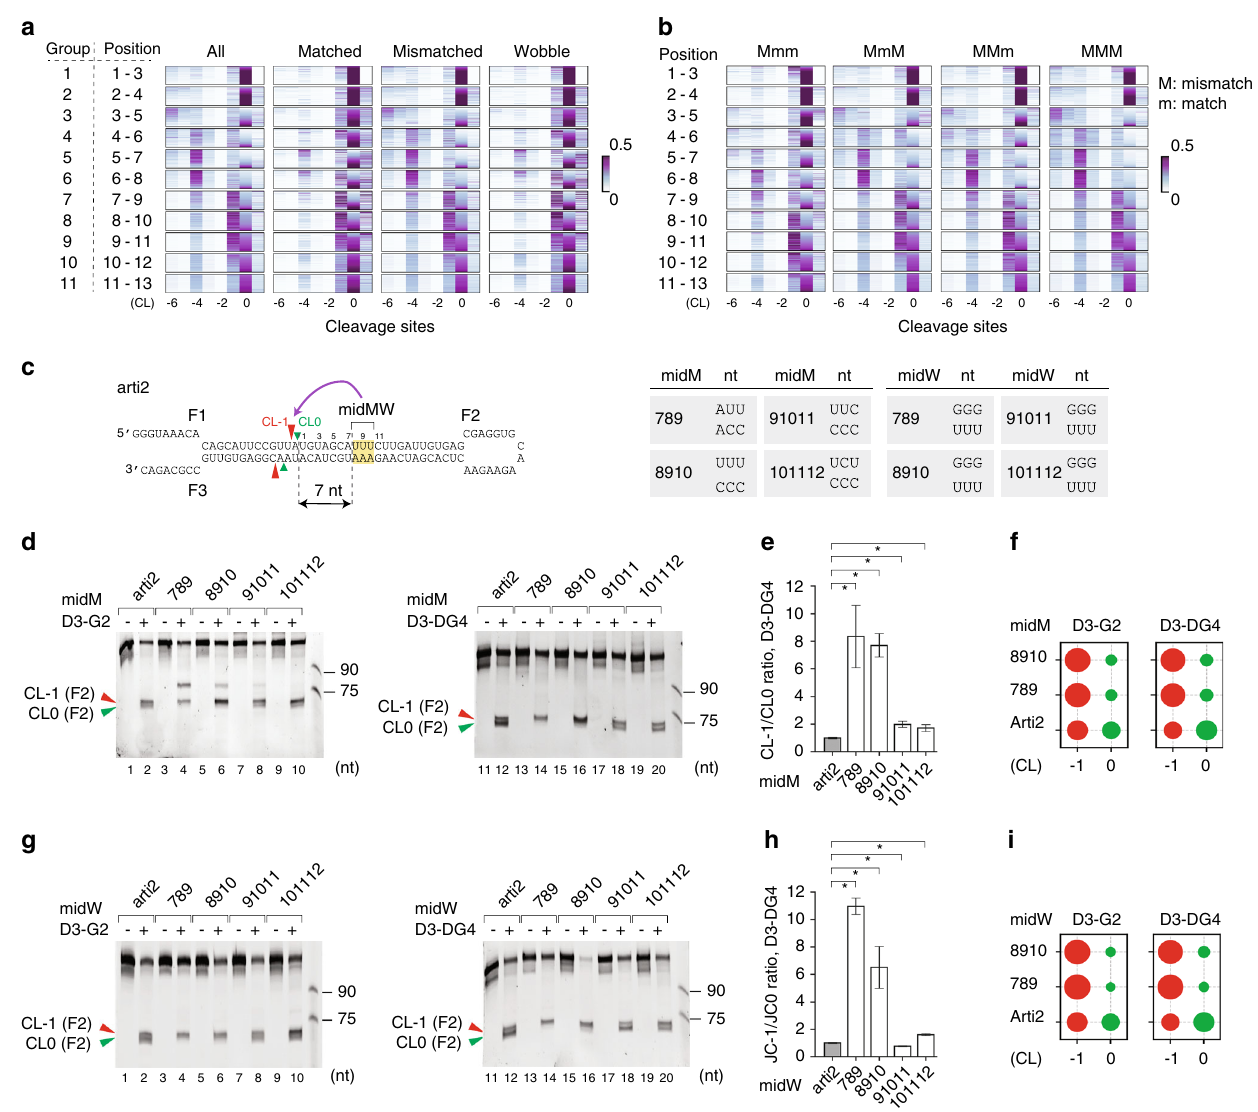
Fig. 2 MidMW causes the alternative cleavage of DROSHA. a The relative positional cleavage frequency of DROSHA at different positions ranging from 7 to 14 nt from the basal junction of each variant from an arti1 individual group, colored according to the color bar (right). Number “ 0 ” indicates the cleavage site 13 nt from the basal junction. The positional cleavage frequency was estimated for all the variants of each group. It was also estimated for three subgroups which contain the matched, mismatched, and wobble variants. b The relative positional cleavage frequency of DROSHA was estimated for each variant containing a different number of mismatches ranging from 1 to 3, colored according to the color bar (right). c Diagram showing the various arti2 variants with mismatches or wobble base pairs at different positions. The red and green arrowheads indicate the CL-1 and CL0 cleavage sites of DROSHA. The table shows the various arti2 variants with mismatches and wobble base pairs at different positions. d , g Processing of arti2 by D3-G2 or D3-DG4. The arti2 variants contain mismatches ( d ) and wobble base pairs ( g ) at different positions. Each RNA (6 pmol) was incubated with D3-G2 (10 pmol) or D3- DG4 (6 pmol) for 120 min at 37 °C in 10 μ l standard reaction buffer as described in the Methods section. e , h The estimated CL-1 to CL0 cleavage ratio of D3-DG4 from experiments conducted in triplicate. The band densities of the F2 fragments resulting from the CL-1 and CL0 cleavage sites were measured using Image Lab v.6.0.1. Data are presented as mean values + / − SEM. The asterisks (*) indicate statistical signi fi cant differences from the two-sided t -test (midM_789 vs. arti2: p = 0.031, midM_8910 vs. arti2: p = 0.001, midM_91011 vs. arti2: p = 0.013, midM_101112 vs. arti2: p = 0.050, midW_789 vs. arti2: p = 7.8e-5, midW_8910 vs. arti2: p = 0.022, midW_91011 vs. arti2: p = 0.010, midW_101112 vs. arti2: p = 0.002). f , i The F2 fragments resulting from the CL-1 and CL0 cleavage sites were cloned and sequenced by NGS. The size of the circle indicates the relative amounts of each F2 fragment from NGS data. The source data are provided in the Source Data fi